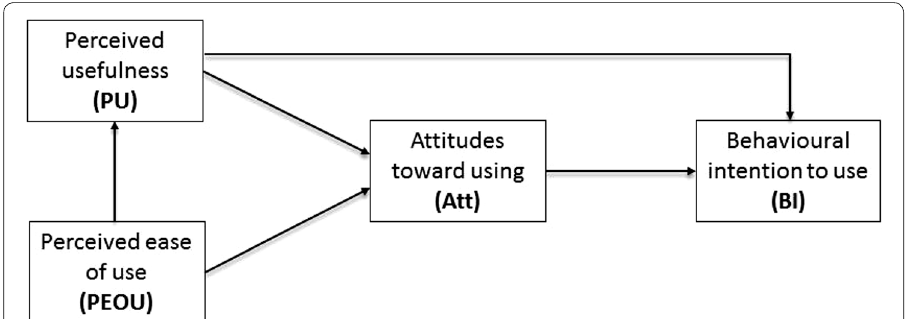
Fig. 1 Technology acceptance model (Partially adapted from Davis et al. (1989), p.